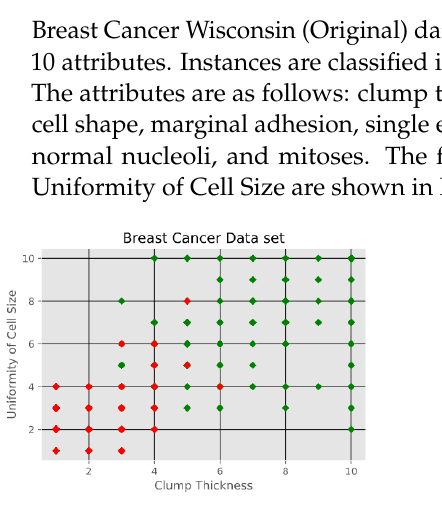
Figure 4. Illustration of the first two attributes of the Breast Cancer data set. 3. and Canadian. The data set contains 210 instances with 7 attributes each. The attrib-